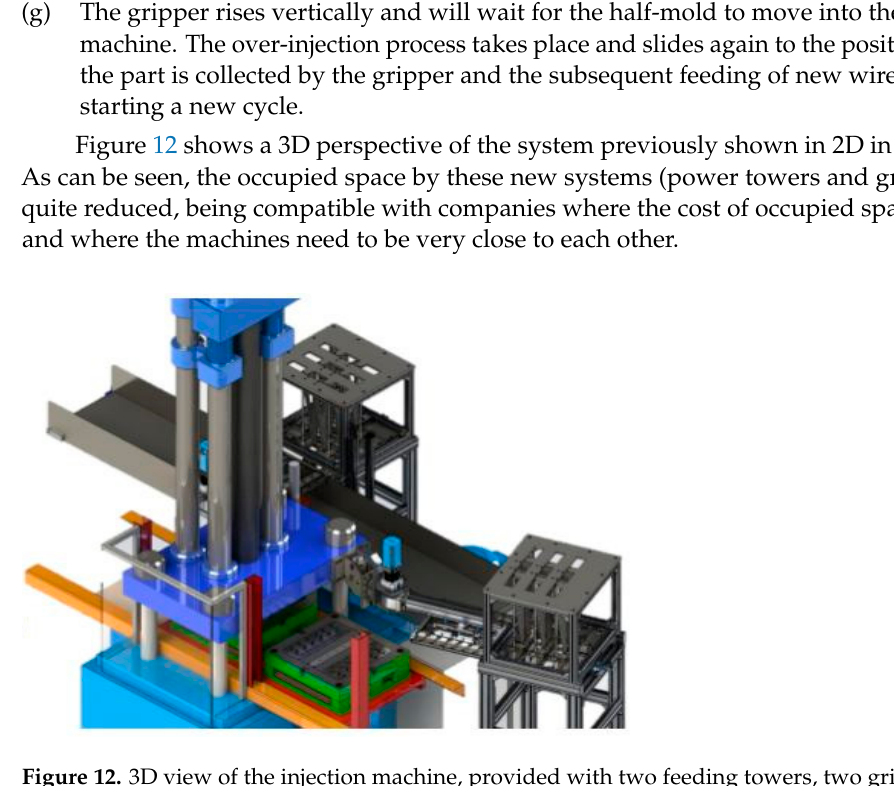
Figure 12. 3D view of the injection machine, provided with two feeding towers, two grippers, and one common conveyor belt.